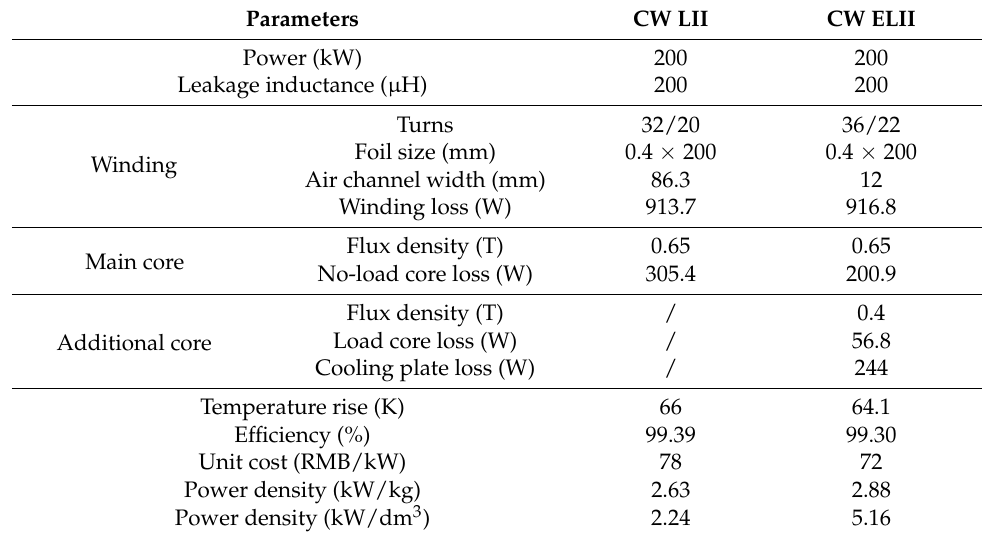
Figure 20. Comparison of CW LII and CW ELII qualified designs. ( a ) CW LII qualified designs; ( b ) CW ELII qualified designs. Table 2. Comparison of CW LII and CW ELII